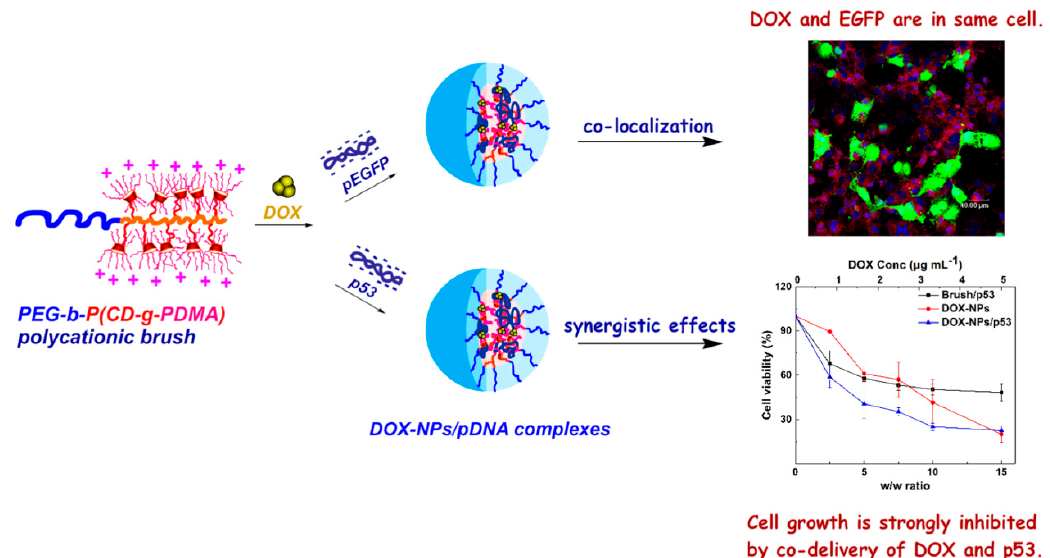
Figure 5. Co-delivery of DOX and pDNA in cationic polymeric nanoparticles with co-localization of cargos and enhanced tumor cell growth inhibition. Reproduced with permission from Chen et al., Polymers; MDPI, 2019 under the license CC BY 4.0 [173].